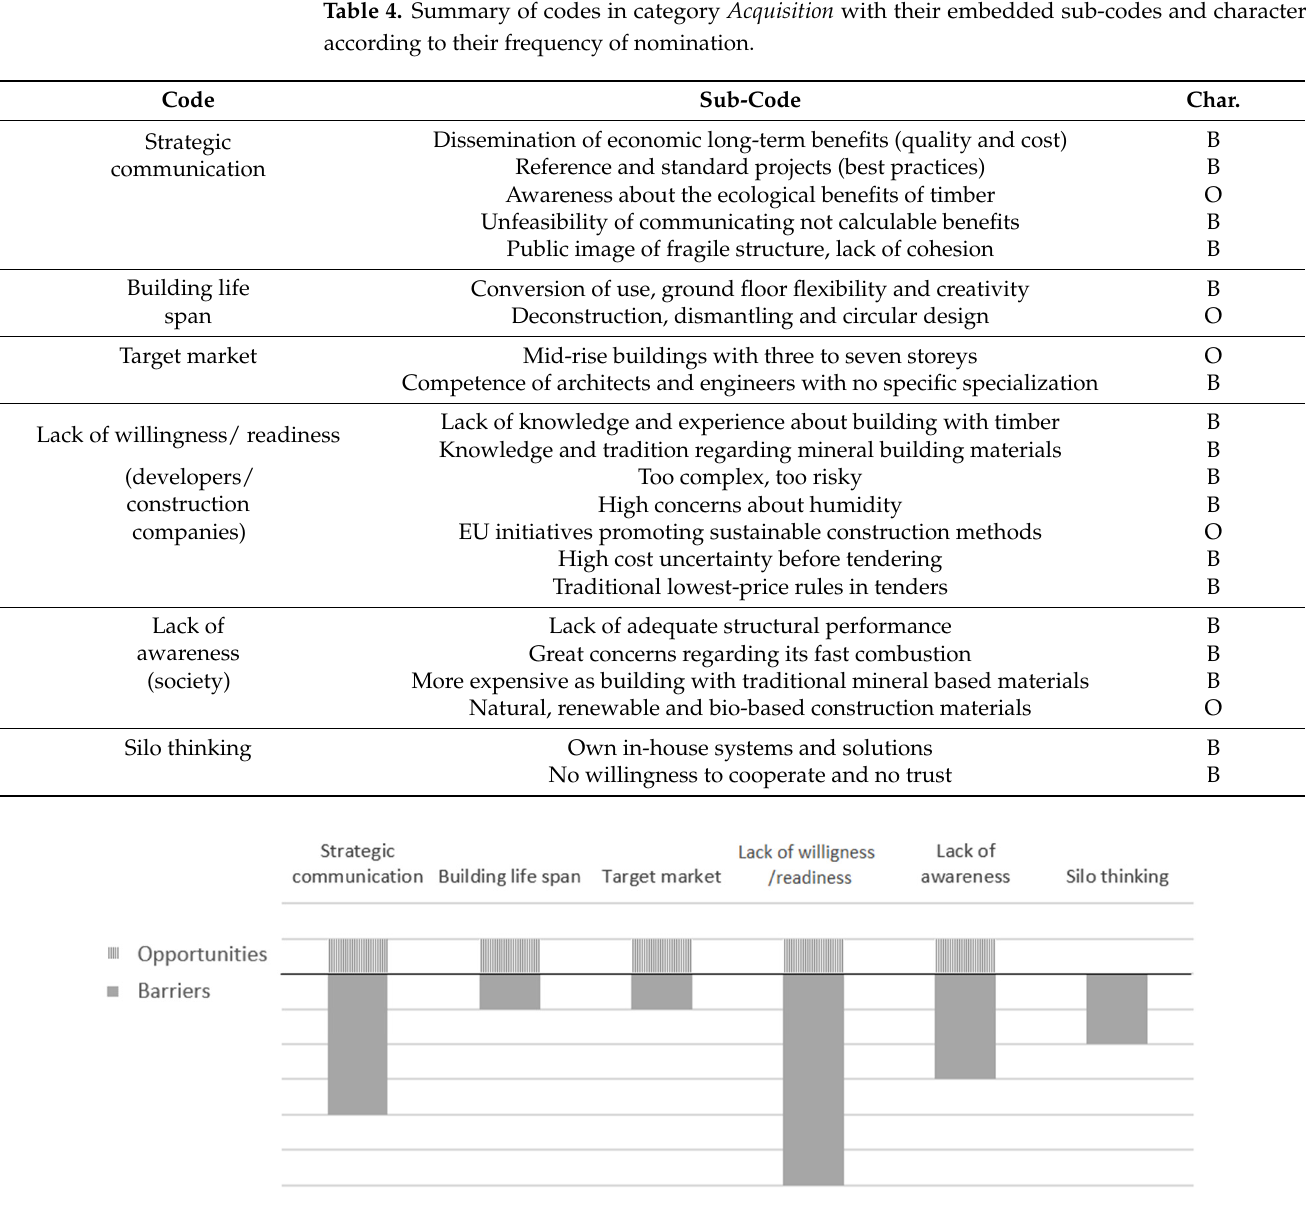
Table 4. Summary of codes in category Acquisition with their embedded sub-codes and character according to their frequency of nomination.